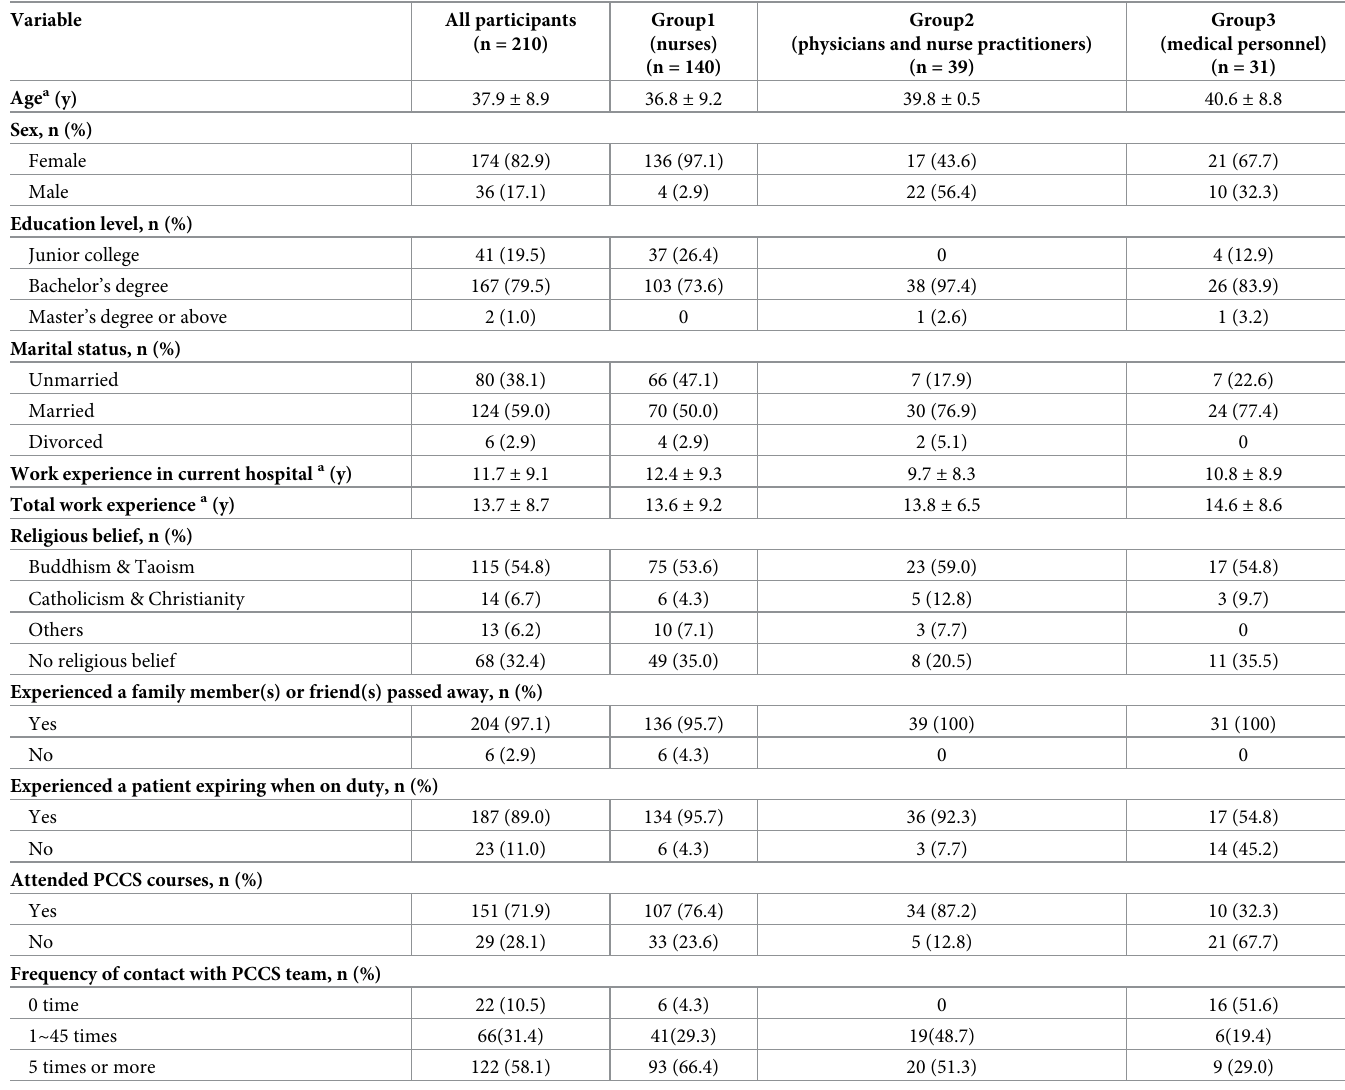
Table 1. Sociodemographic data